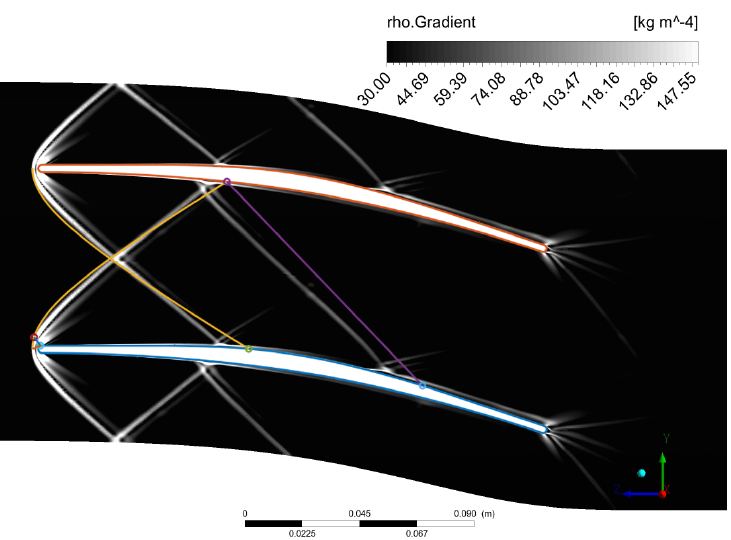
Figure 8. Comparison between CFD numerical Schlieren in background and the analytically deter- mined shocks in foreground (detached shock in yellow and reflected shock in purple in the online colored